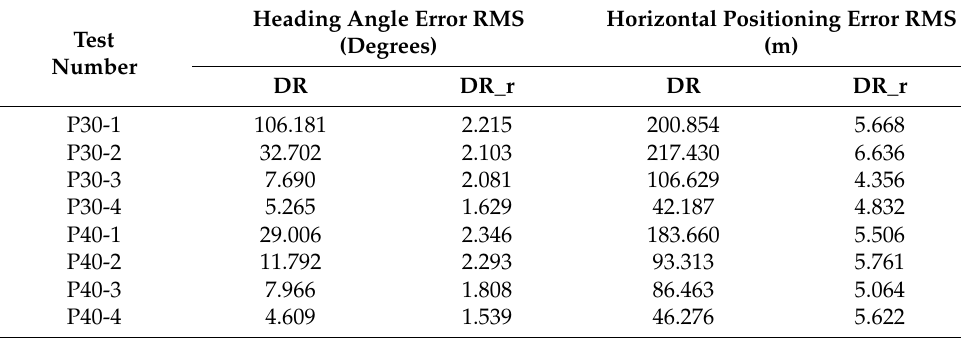
Table 1. Error statistics for heading angle and horizontal positioning error.